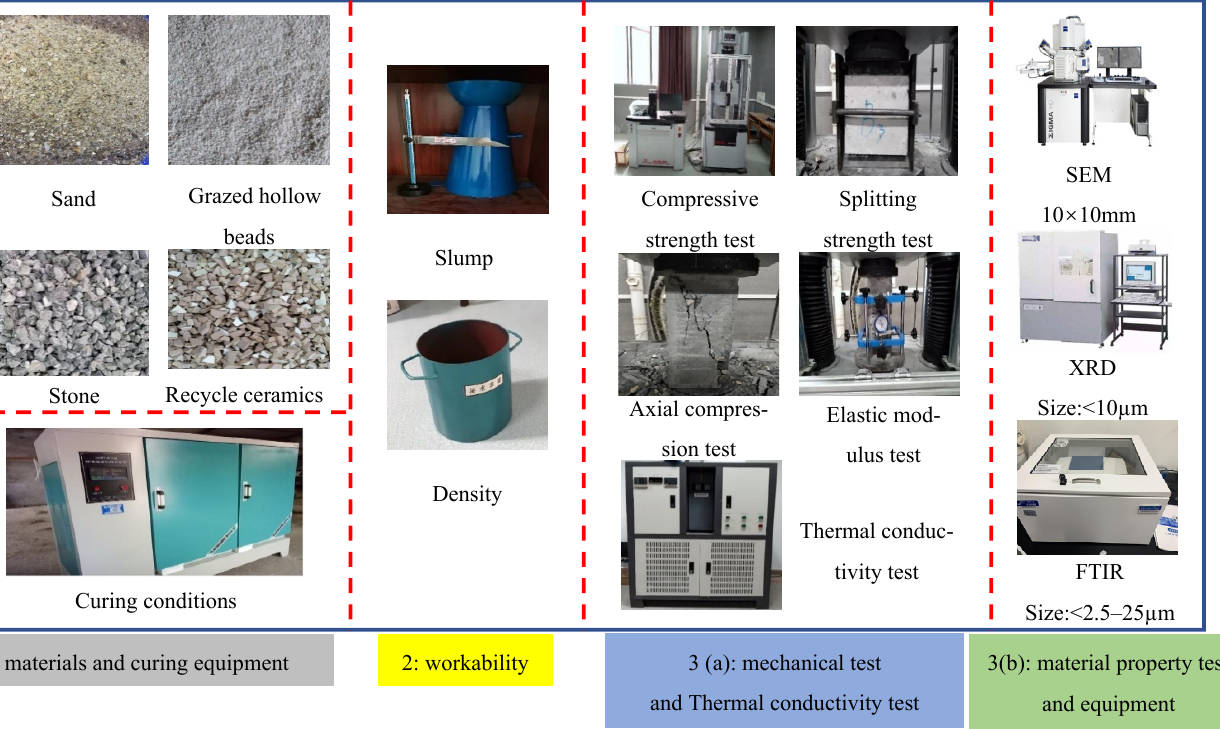
Figure 5. Experimental flowchart.